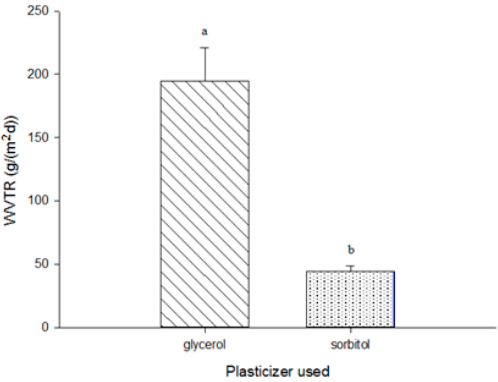
Figure 7. Water-vapor transmission rate of protein films from jumbo squid ( Dosidicus gigas ) with glycerol and sorbitol as plasticizers. The values are the means of five determinations ± the standard deviation. Different letters show significant differences ( p < 0.05).